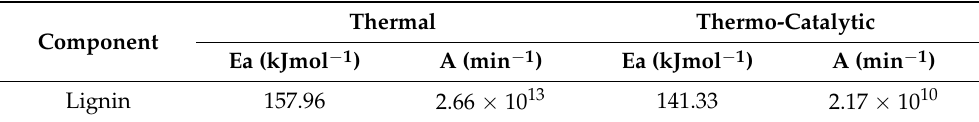
Table 1. Determination of Kinetic parameters applying Kissinger equation.